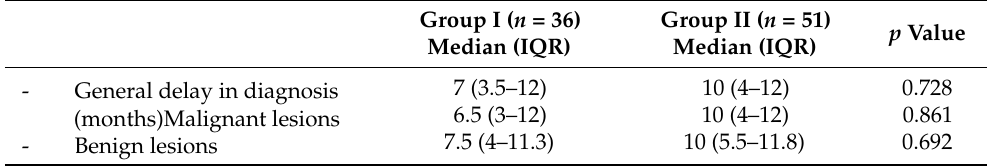
Table 2. Delay in diagnosis and results of further diagnostic and therapeutic pathway of bone neoplasms. The Mann–Whitney U test was used to compare the variables. IQR—interquartile